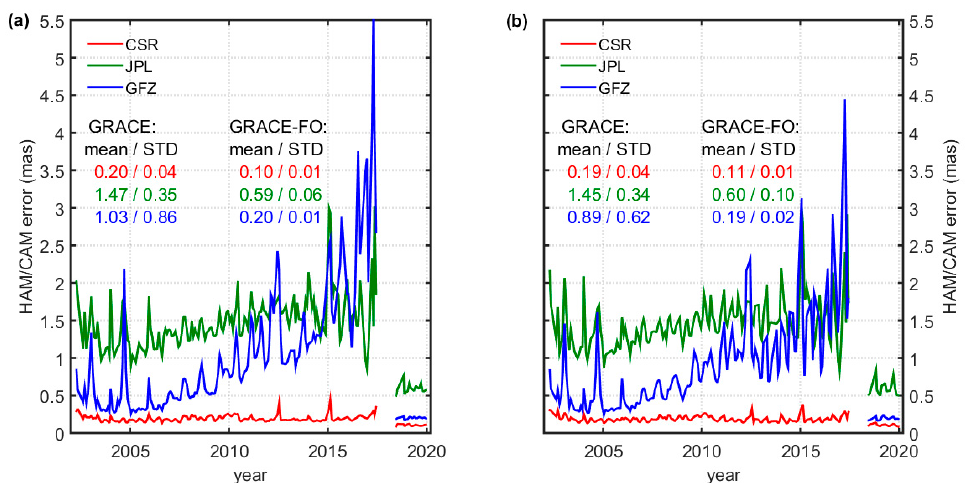
Figure 2. Errors of χ 1 ( a ) and χ 2 ( b ) components of HAM/CAM obtained from GRACE Level-2 data. The errors were computed from formal errors of Δ C 21 , Δ S 21 coefficients. Mean errors and STD of errors are added for each time series.